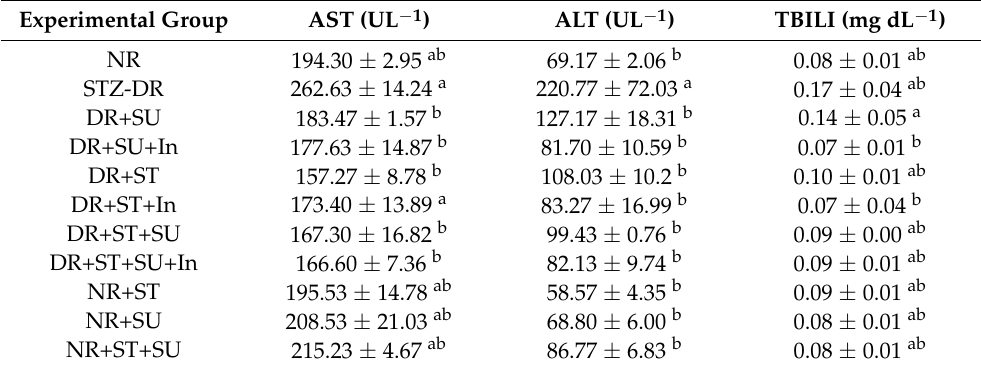
Table 2. Effects of stevioside and sucralose and their combination on serum biochemical liver markers in STZ-induced diabetes in rats, n = 6.